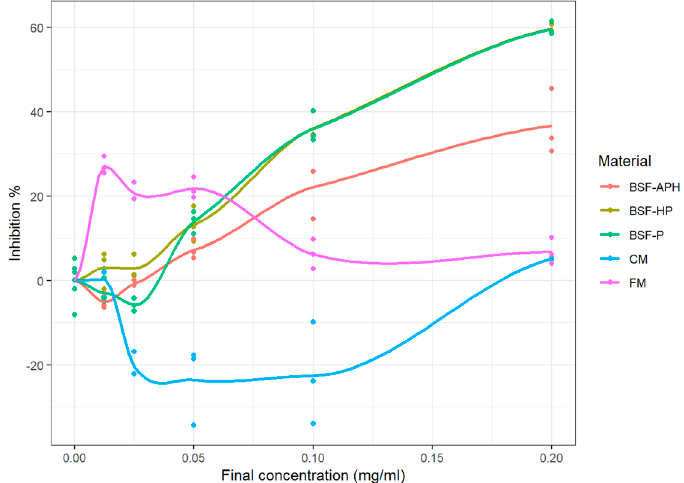
Figure 5. Neutrophil response modulation activity of PureeX TM (BSF-P), PureeX proTM (BSF-HP), ProteinAX proTM (BSF-APH), chickenmeal (CM) and fishmeal (FM) (n = 3).